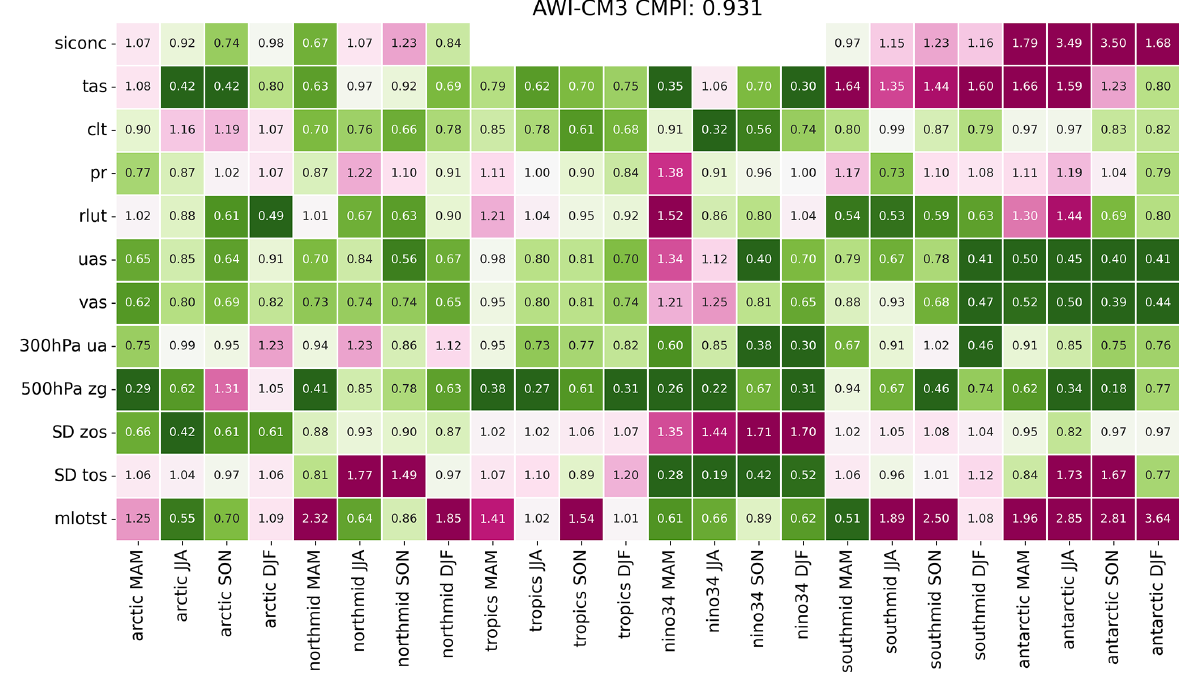
Table 1. Performance indices after Reichler and Kim (2008) that give the absolute error in climatology of the last 25 years in AWI-CM3 historic simulation as a fraction of the absolute error averaged over CMIP6 models. Values below (above) 1 correspond to below (above) CMIP6 average biases. The underlying observations against which all models were evaluated are OSI SAF OSI-450 (Lavergne et al., 2019) – sea ice concentration (siconc); MODIS Atmosphere L2 Cloud Product (Platnick et al., 2015) – cloud cover (clt); Global Precipitation Climatology Project (GPCP) Monthly analysis (Adler et al., 2018) – precipitation (pr); Clouds and the Earth’s Radiant Energy System (CERES) (Wielicki et al., 1996) – TOA outgoing longwave radiation (rlut); ECMWF reanalysis ERA5 (Hersbach et al., 2020) – near- surface air temperature (tas), eastward near-surface wind (uas), northward near-surface wind (vas), 300hPa eastward wind (ua), and 500hPa geopotential height; NOAA Jason-1, Jason-2, and CryoSat-2 combined – sea surface height (zos); HadISST2 (Titchner and Rayner, 2014) – sea surface temperature (tos); and C-GLORSv7 (Storto et al., 2016) – mixed-layer depth (mlotst). A full list of the considered CMIP6 models is given in Appendix